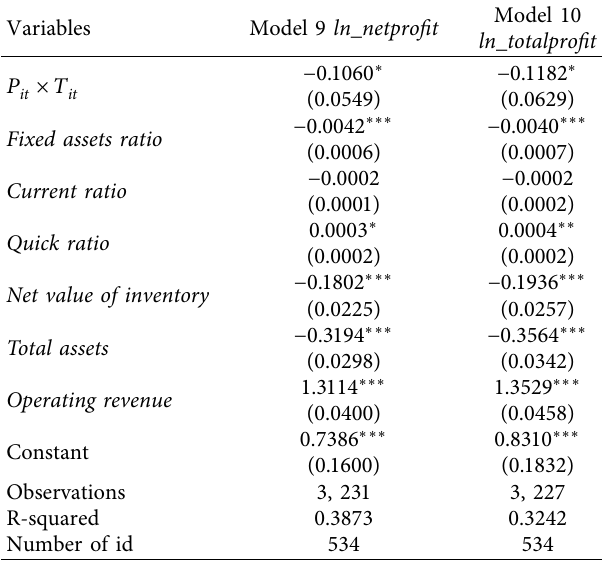
Table 3: Mechanistic analysis of net profit and total profit.